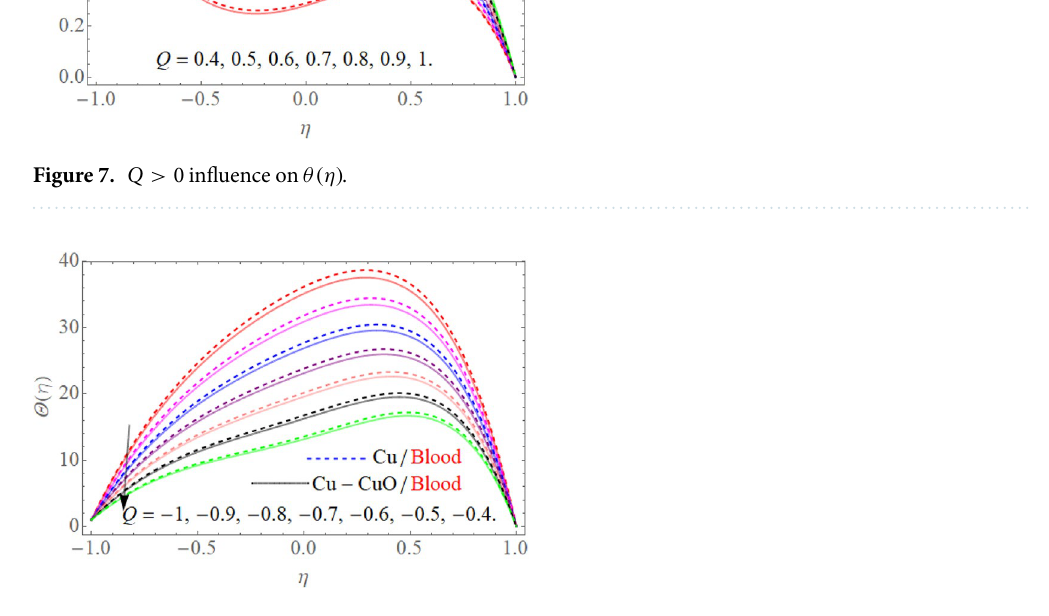
Figure 8. Q < 0 influence on θ(η)